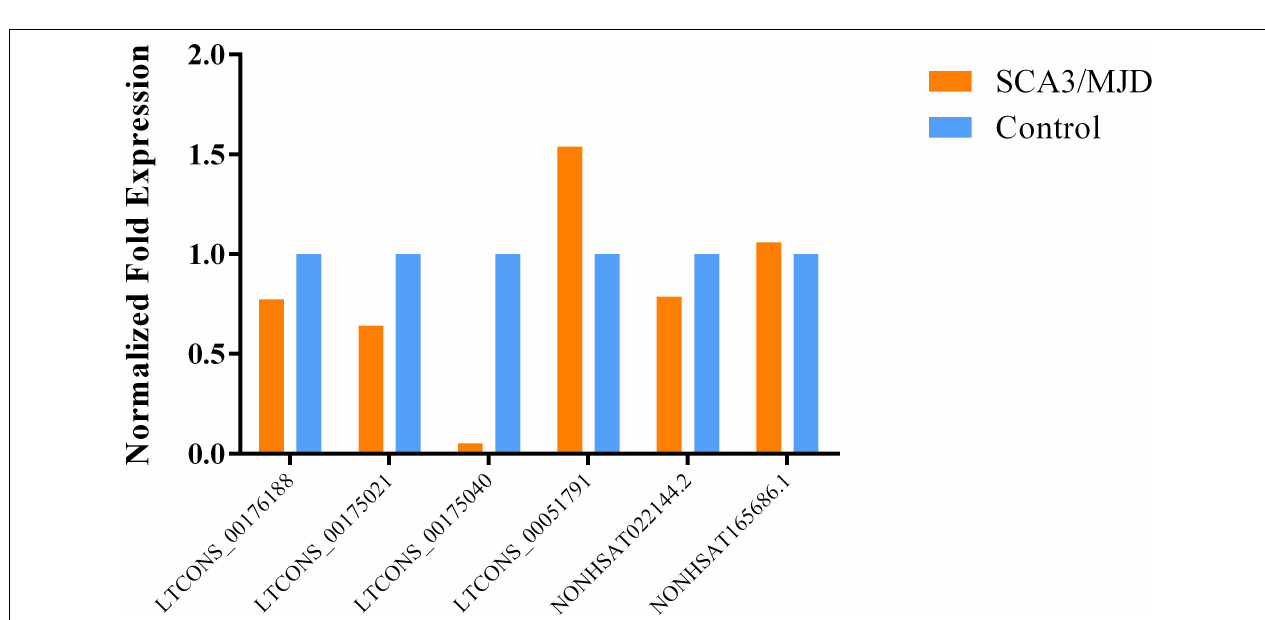
FIGURE 5 | The expression level of statistically significant DEGs in PBMCs. The expression levels of NONHSAT165686.1, LTCONS_00175040, LTCONS_00175021, and LTCONS_00051791 are up-regulated.Compared with the control group, the expression level of NONHSAT165686.1 is about 5.6 times ( p = 0.036), the expression of LTCONS_00051791 is about 4.8 times ( p = 0.018), and LTCONS_00175021 and LTCONS_00175040 are both up more than twice ( p = 0.027 of LTCONS_00175021 and p = 0.032 of LTCONS_00175040). Contrary to this, both known lncRNA NONHSAT022144.2 and novel lncRNA LTCONS_00176188 are down-regulated, their expression levels are 0.259 times ( p = 0.000) and 0.640 times ( p = 0.043) that of the control group, respectively.